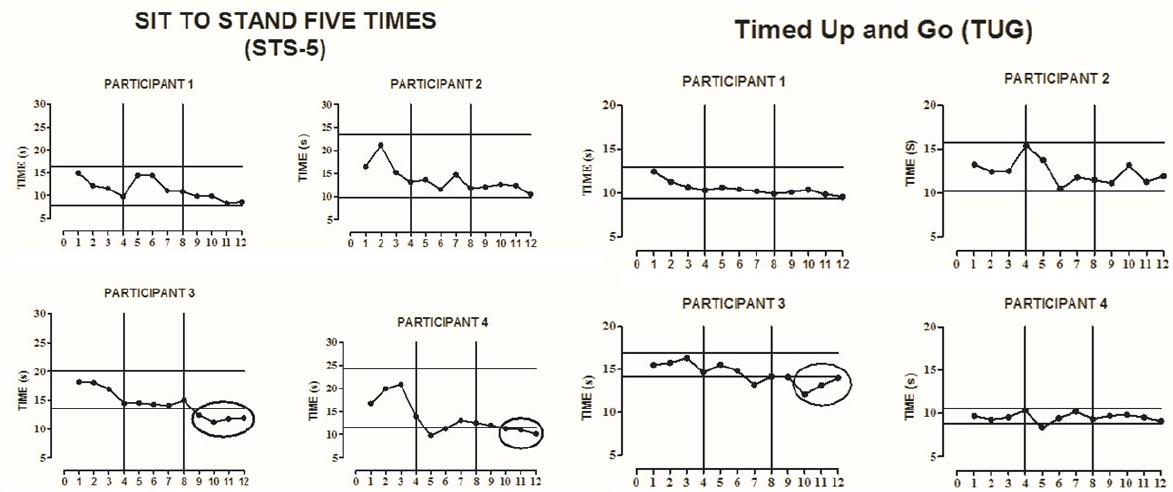
Figure 4. Visual representation of the Sit to Stand Five Times (STS-5) and Timed Up and Go (TUG) at baseline, intervention, and follow-up phases for participants 1, 2, 3, and 4 ( P1 – P4 ). The solid horizontal lines indicate ± 2 standard deviations from the mean of the baseline data. The x-axis represents the phases A–B-follow up, and the vertical lines divide the phases. The circles that encompass data showed a change trend after a graphic visual inspection of the baseline.